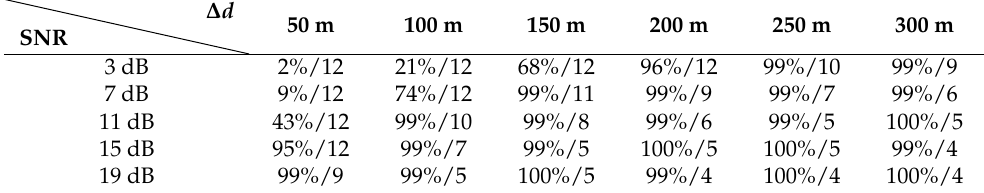
Table 3. Radar subset under different deception distances and